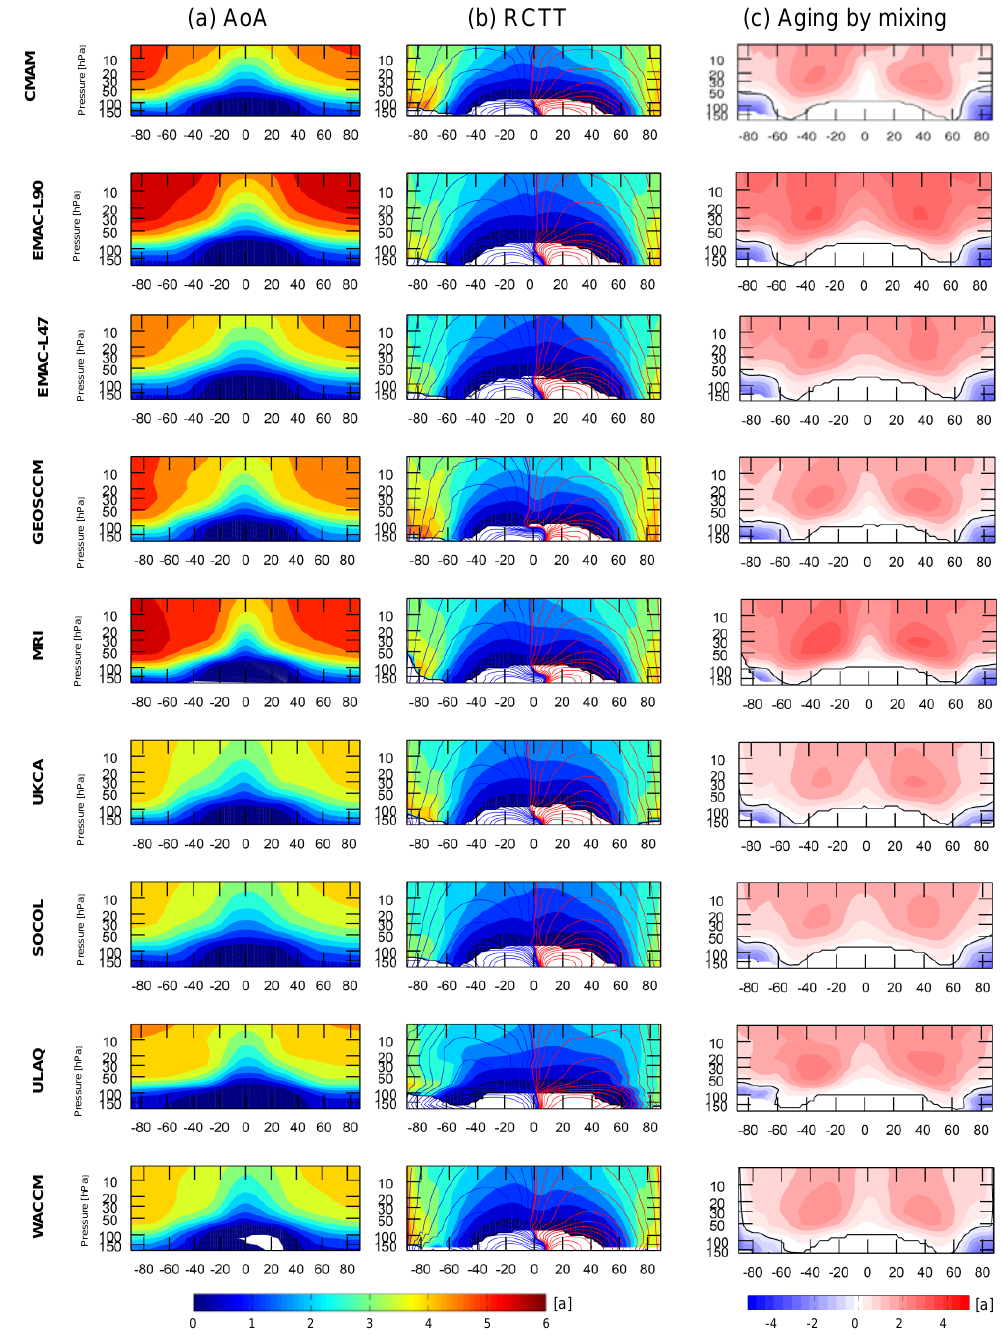
Figure 2. As Fig. 1, but annual means show the average over the years 1980–2010 for the REF-C1 simulations of CCMI-1.